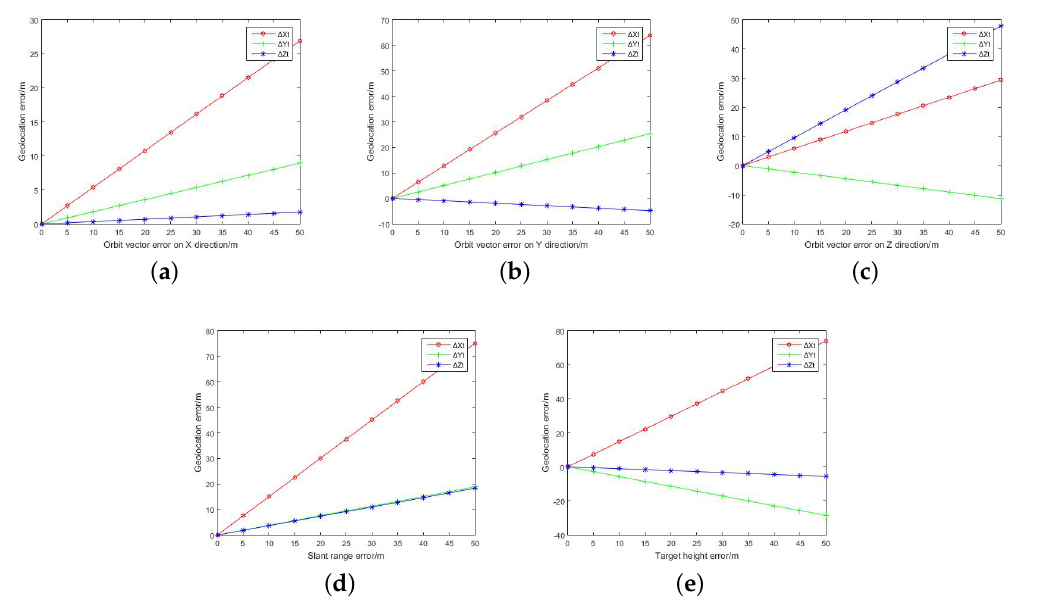
Figure 4. The relationship between error in different SAR parameters and geolocation error on 20100623 and 20100808: ( a ) shows geolocation error when error added in X direction of orbit vector. ( b – e ) are geometric deviation changing with Y s , Z s , R and h